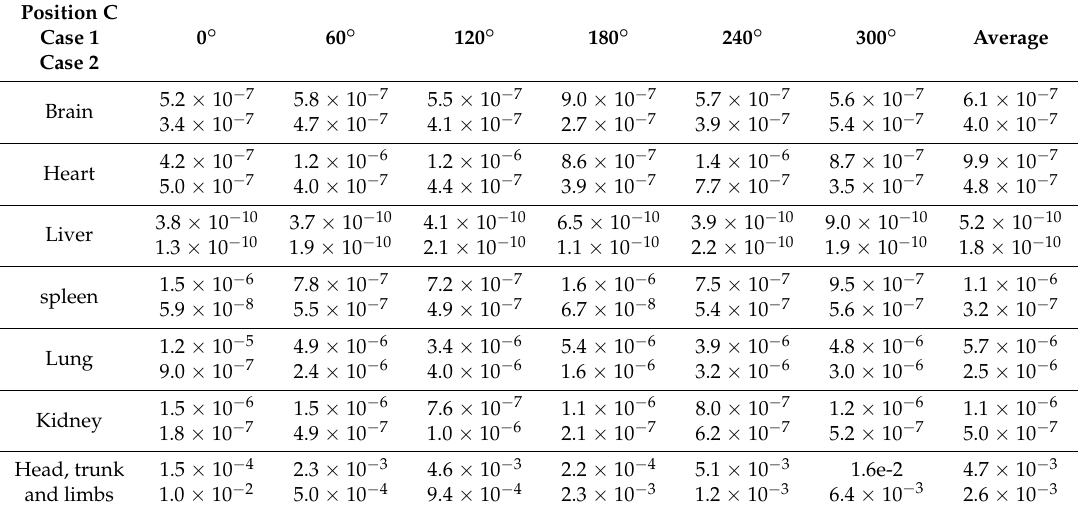
Table 6. The peak spatial-average SAR values (W/kg) in typical tissues with different orientations in position C.